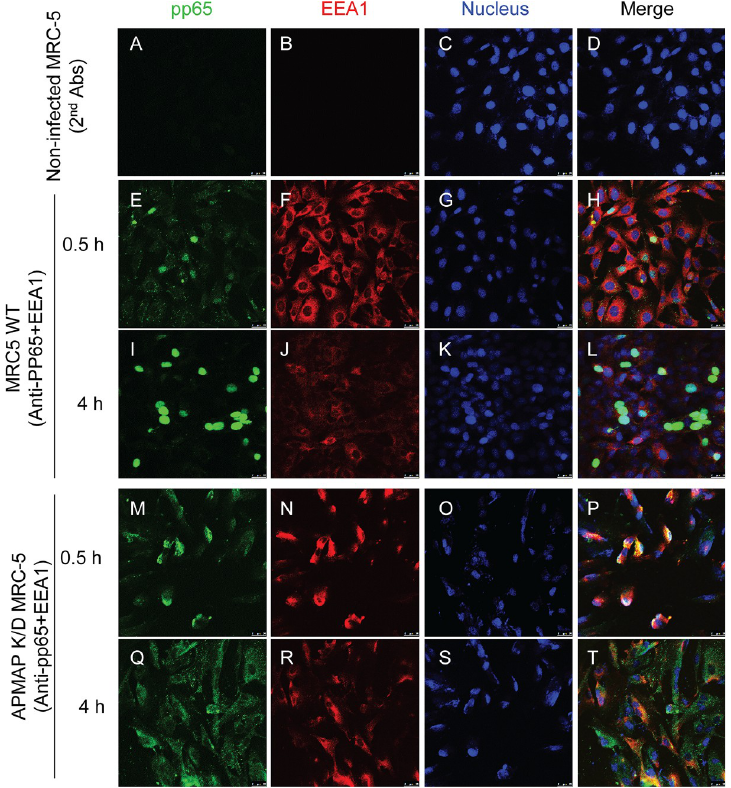
Fig 8. Delayed pp65 nucleus translocation in APMAP K/D MRC-5 cells. ( A-L ) Wildtype MRC-5 and ( M-T ) APMAP K/D cells were seeded in chamber slides (1.5 × 10 4 cells/well) for 1 day. The cells were pre-cooled at 4˚C before adding AD169rev for attachment at 4˚C for 1 h to synchronize virus infection. Then, the cells were transferred to 37˚C and cultured for 0.5 h or 4 h before fixation with 4% PFA. The cells were double stained with mouse anti-pp65 and Rabbit anti-EEA1 antibodies and corresponding Fluorescence labelled secondary antibodies. Nuclei were stained by DraQ5. The pictures were taken using LEIKA confocal microscopy. Bar = 25 μ m.